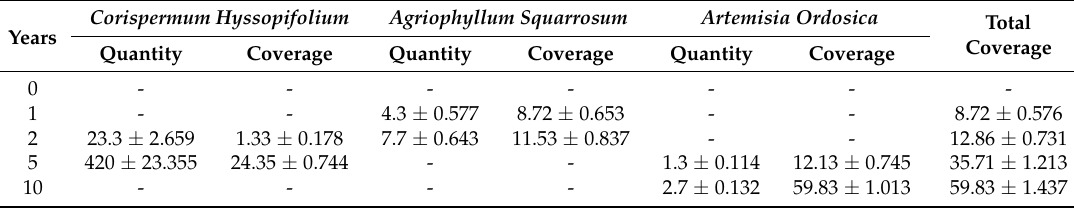
Table 3. Vegetation recovery in the years after a sand barrier was constructed on a